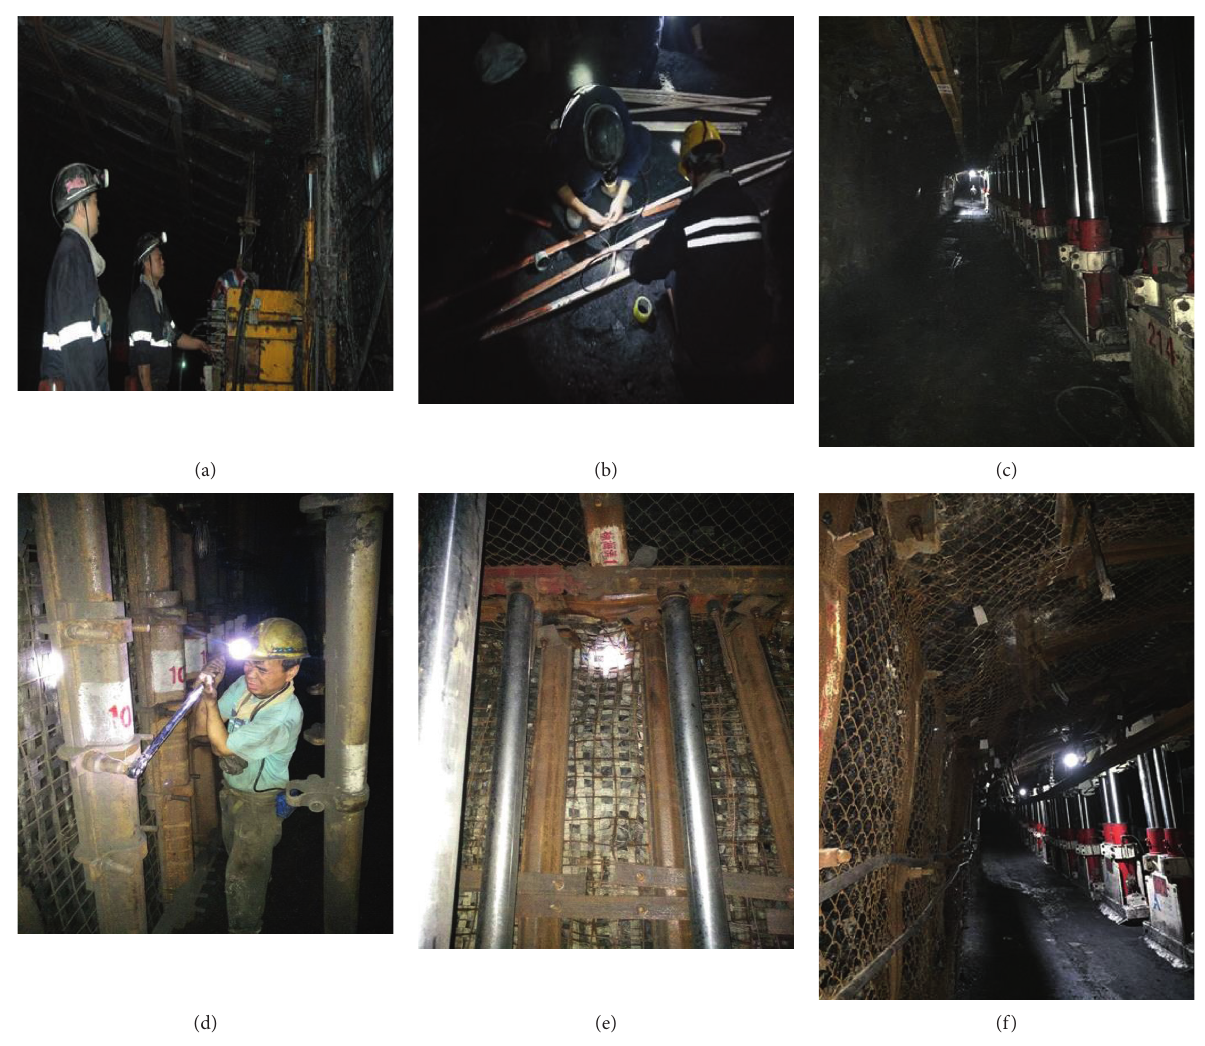
Figure 13: Site photographs of the implementation of surrounding rock control technology for retaining roadway along goaf. (a) Construction of blasting drilling. (b) Explosive assembly. (c) Pile support advance support. (d) Erection of gangue retaining column. (e) Actual effect of gangue retaining. (f) Effect of Retaining Roadway along